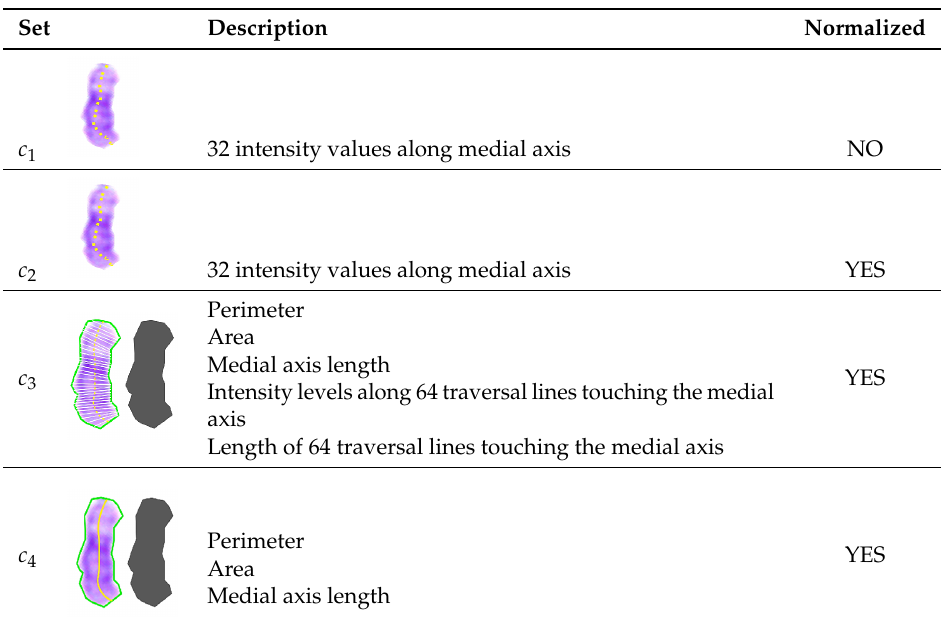
Table 1. Subset of features { c 1 , c 2 , c 3 , c 4 } ⊆ C .